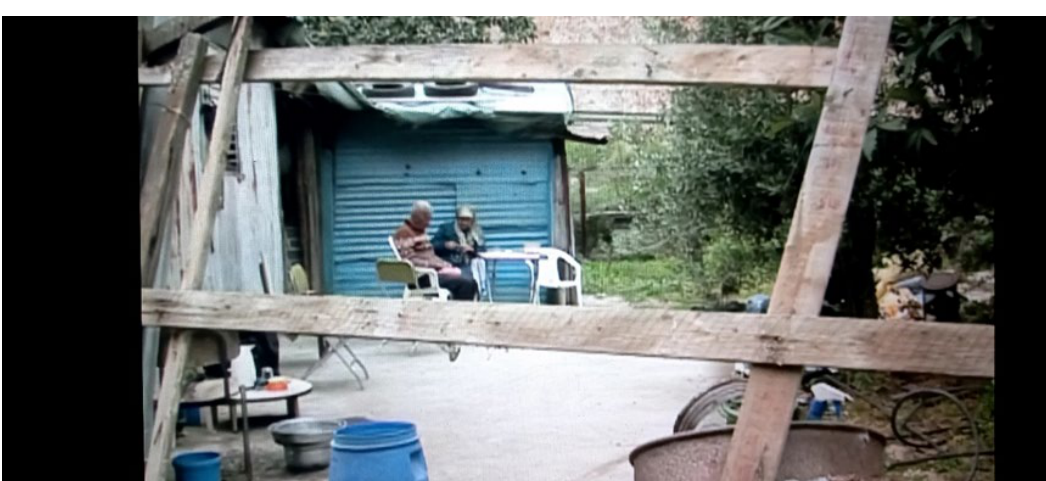
Figure 10 Amna and Yousuf in the courtyard of the shack, Source: 'Roshmia', Salim Abi-Jabel,